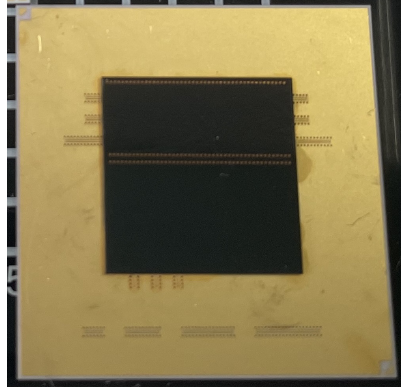
Figure 11. FOWLP soldered on the ceramic